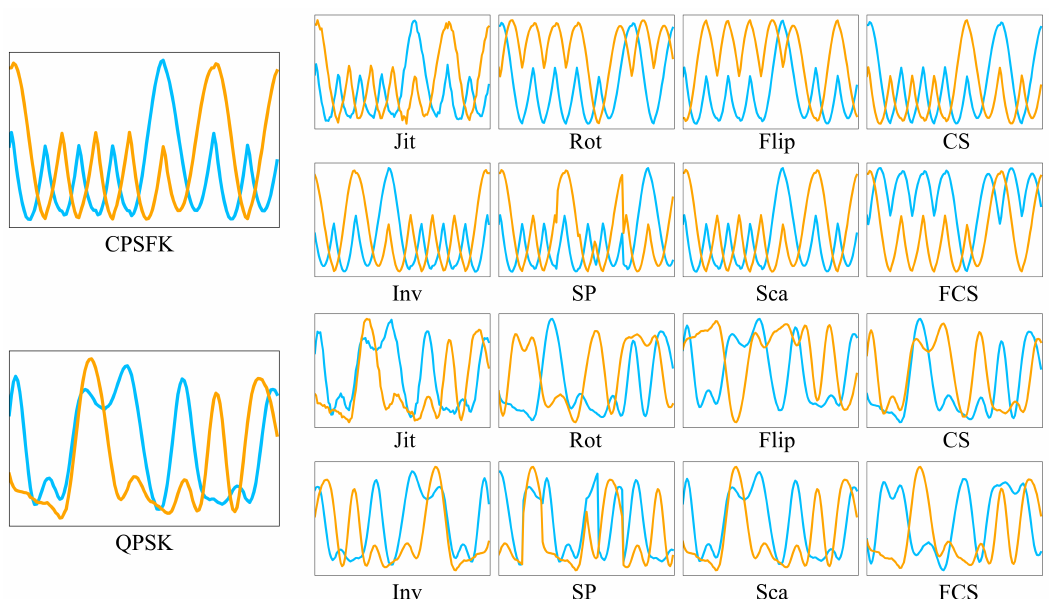
Figure 1. Example of 8 transforms for CPSFK and QPSK samples. For the raw IQ samples, the blue curve represents the I component, and the orange curve represents the Q component. Despite the inclusion of several possible transformations, such as Rot, Flip, and SP, only one of these forms is shown in the